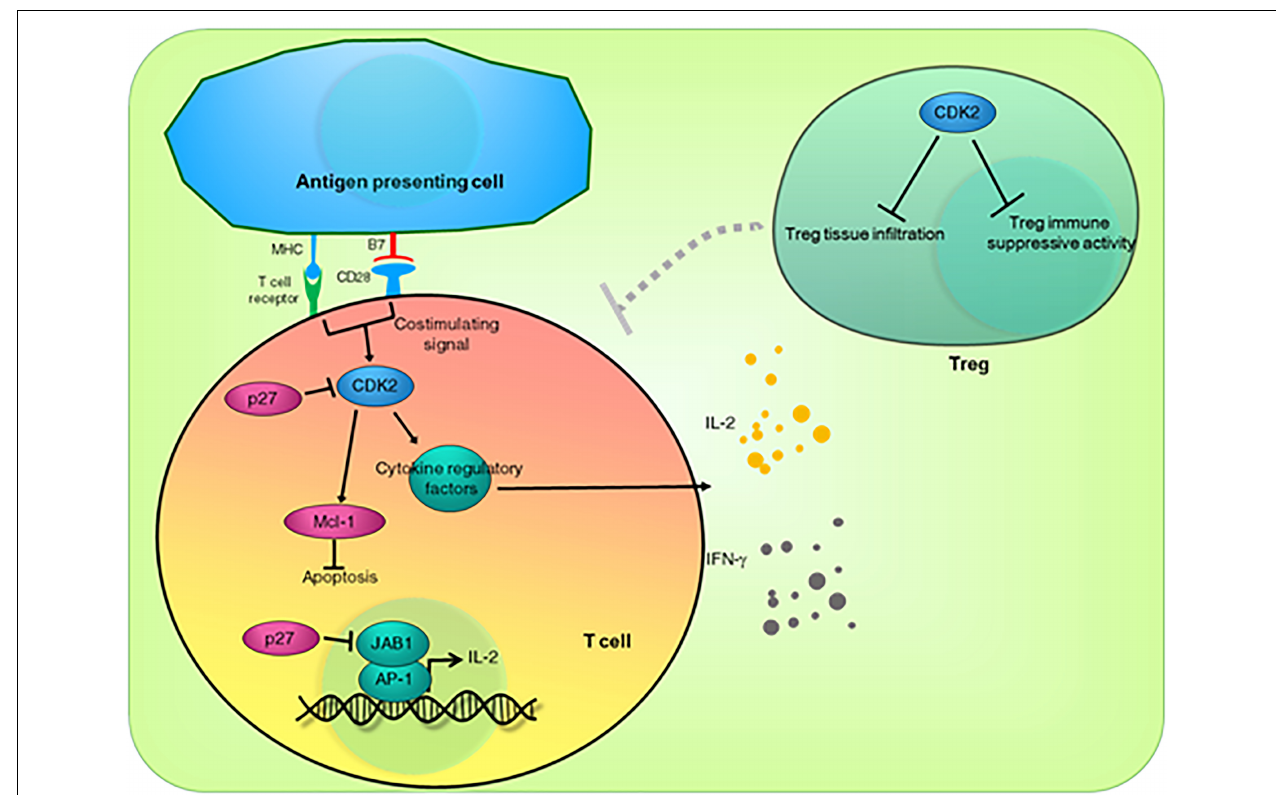
FIGURE 2 | Direct roles of CDK2 and CDK inhibitor p27 KIP1 in T cell anergy. CDK2 is a mediator for co-stimulating signals. CDK2 activity is required for the activity of antigen-activated T cells. CDK2 may contribute to activated T cell survival by upregulating the anti-apoptotic protein Mcl-1. p27 KIP1 inhibits CDK2 activity, which in turn acts as an “off” switch for activated T cells. In addition, independent of its CDK2-inhibitory function, p27 KIP1 sequesters JAB-1 from the AP-1 transcriptional complex, leading to downregulated IL-2 expression. CDK2 also inhibits Treg activity and tumor infiltration, further de-repressing the function of immune